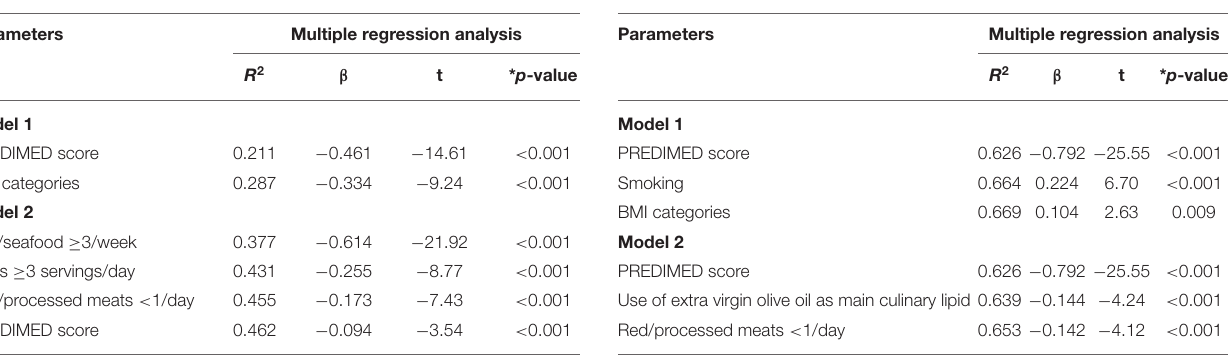
TABLE 11 | Multiple regression analysis models (stepwise method) with the cytology categories (TIR2, TIR3a, TIR3b vs. TIR4/TIR5) as a dependent variable to estimate the predictive value of sex, lifestyle characteristics, BMI categories, PREDIMED scores, and each item included in PREDIMED